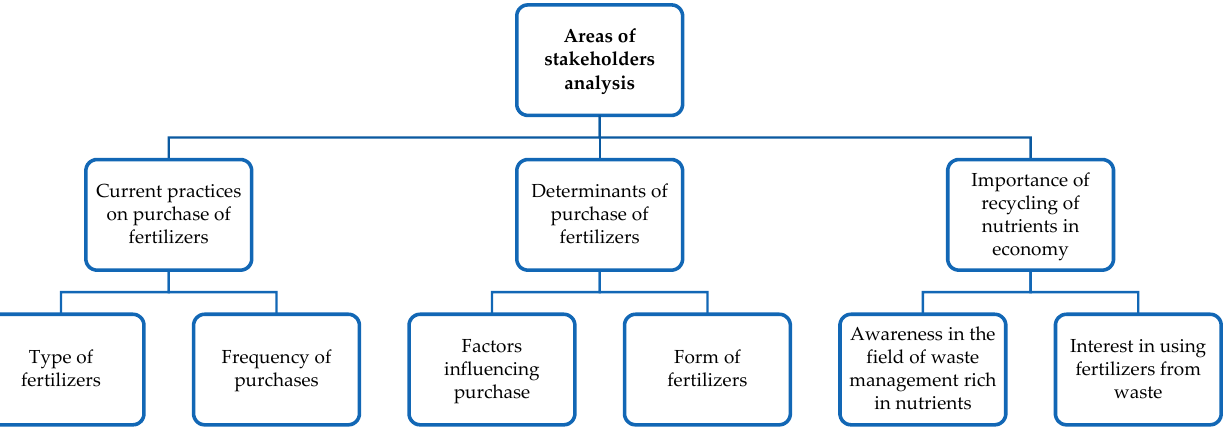
Figure 1. Research areas of stakeholder analysis.